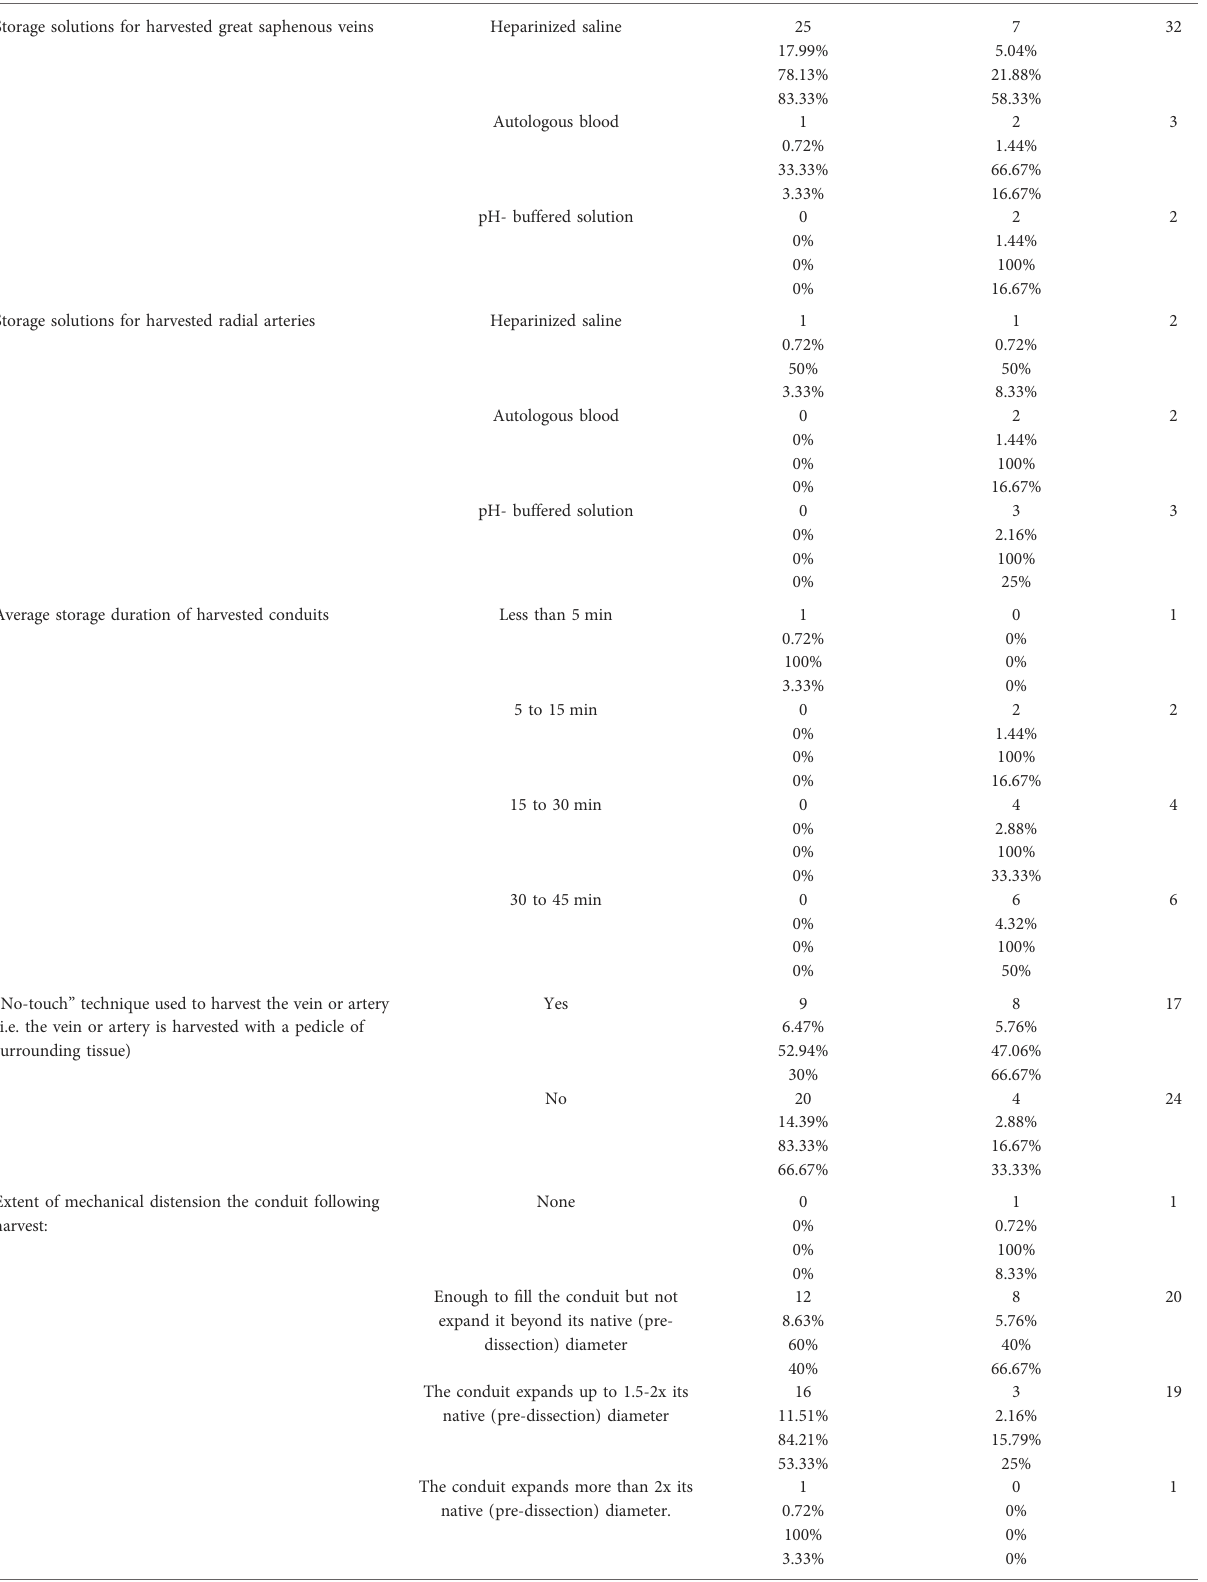
TABLE 1 Distribution of storage solutions, storage duration, “ no-touch ” harvesting and degree of conduit distension by surgical specialty a . Vascular Surgery Cardiothoracic Surgery Total